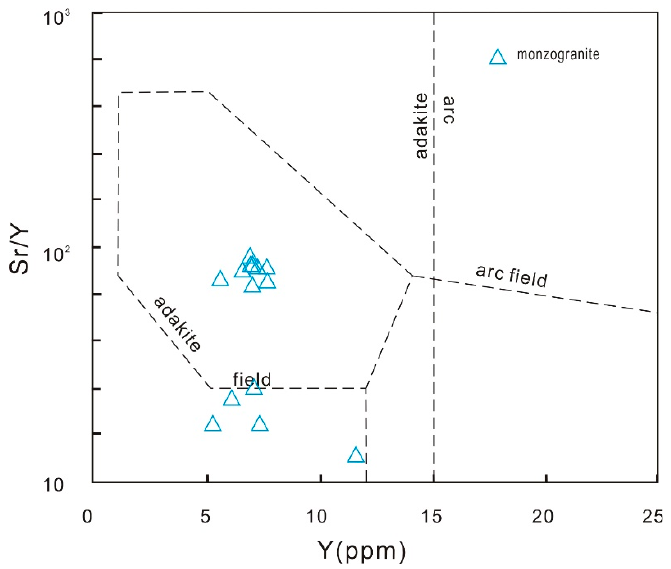
are the same as in Figure 7.